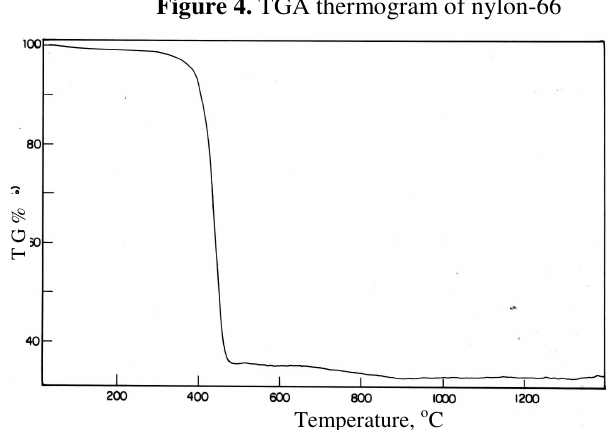
Figure 5. TGA thermogram of GF